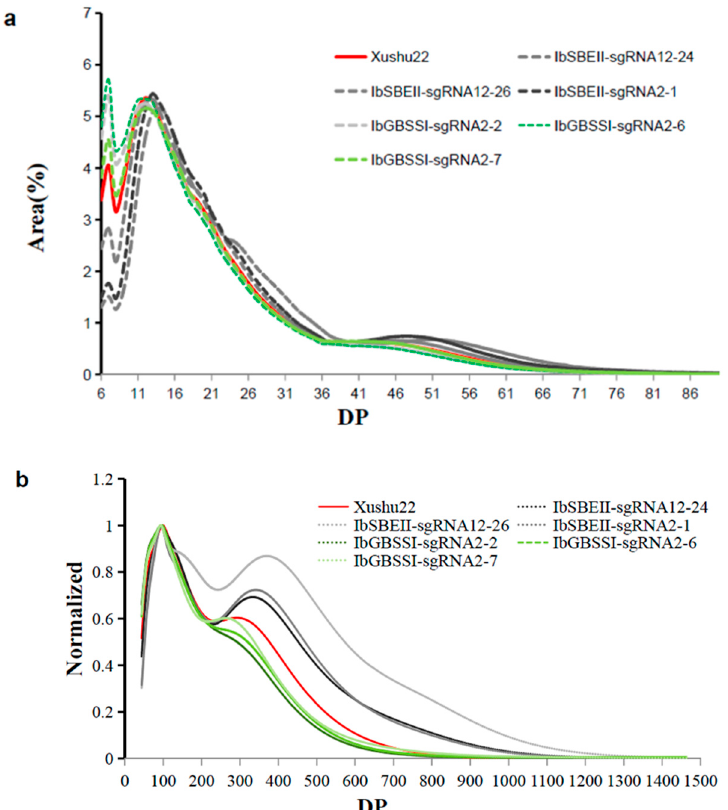
Figure 5. Chain length distributions of debranched sweet potato starches in transgenic lines. ( a ) Chain length distributions detection for the short chain of 90 > DP > 6 in Xushu22 and transgenic plant lines. ( b ) Chain length distributions detection for the long chain of DP > 43 in Xushu22 and transgenic plant lines.